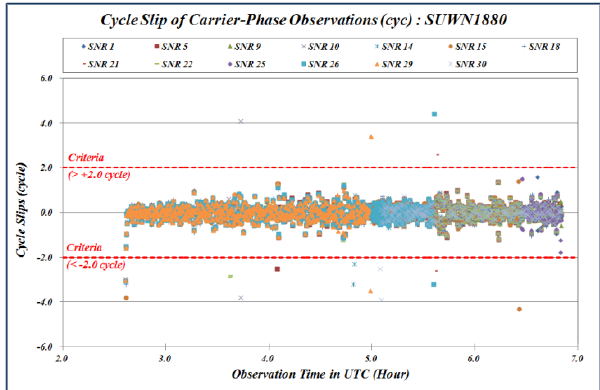
Figure 7. Quality control indicators related to cycle slip effects ( cyc ) as shown in the time- series plots at each observation